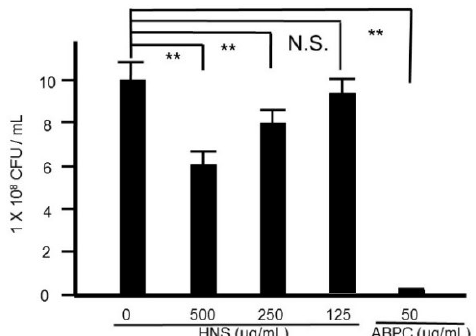
Figure 1. Suppressive effects of the hainosan extract (HNS) on the bacterial growth. S. mutans cells were treated with HNS for 24 h. Data points represent the number of viable cells in a culture medium or culture medium containing HNS and are presented as the means ± S.D. ( n = 6). **: p < 0.01 by Tukey’s multiple comparison tests. NS: not significant.